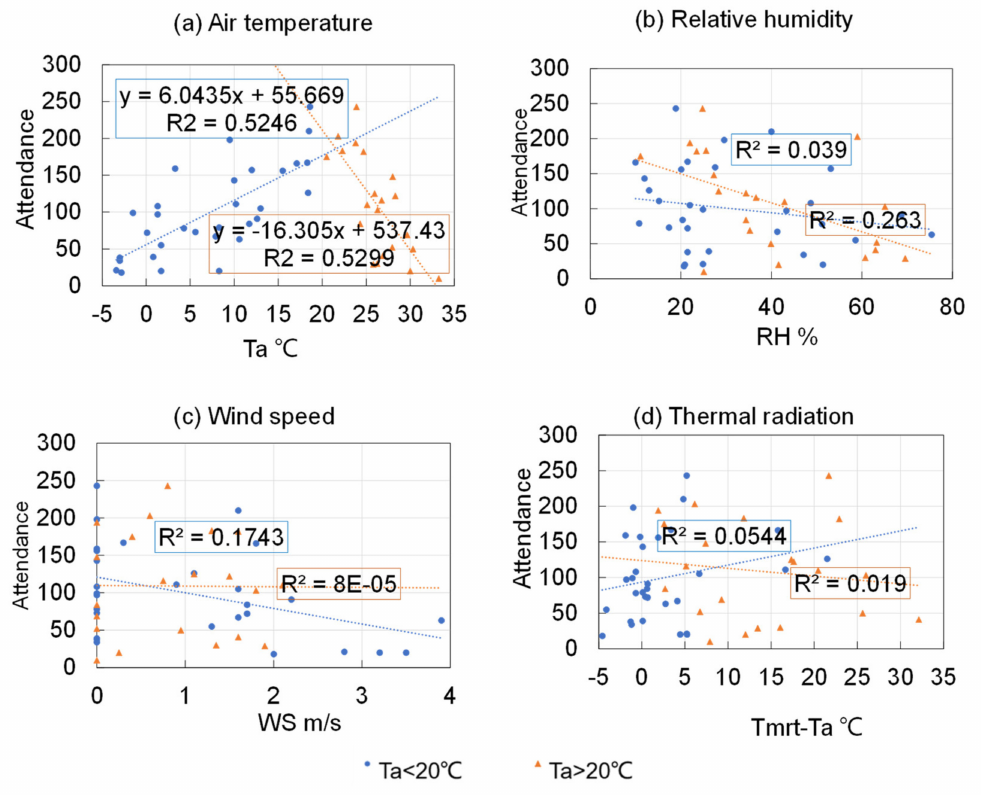
Figure 7. Occupant attendance of optional activities under different air temperatures for: ( a ) Air temperature, ( b ) Relative humidity, ( c ) Wind speed, and ( d ) Thermal